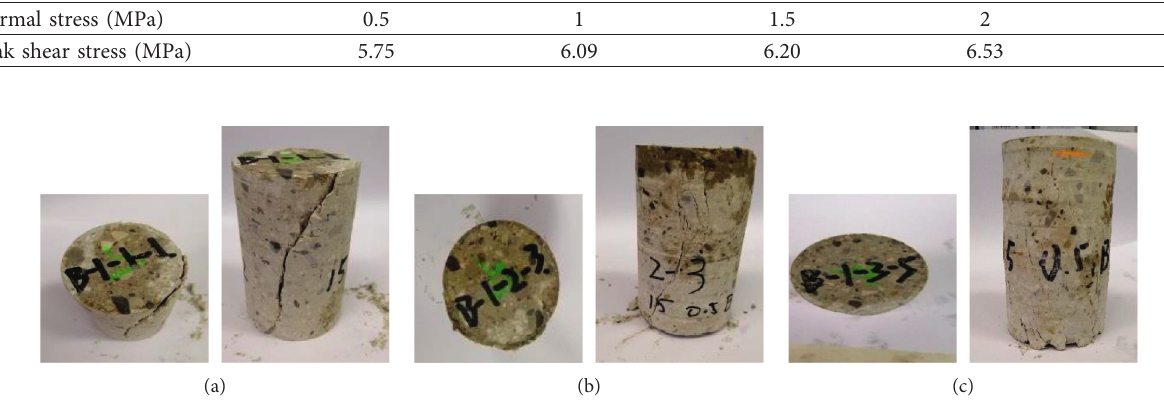
Figure 12: The failure state of some specimens. (a) The state of the specimen B-1-1-1 after the triaxial test. (b) The state of the specimen B-1- 2-3 after the triaxial test. (c) The state of the specimen B-1-3-5 after the triaxial